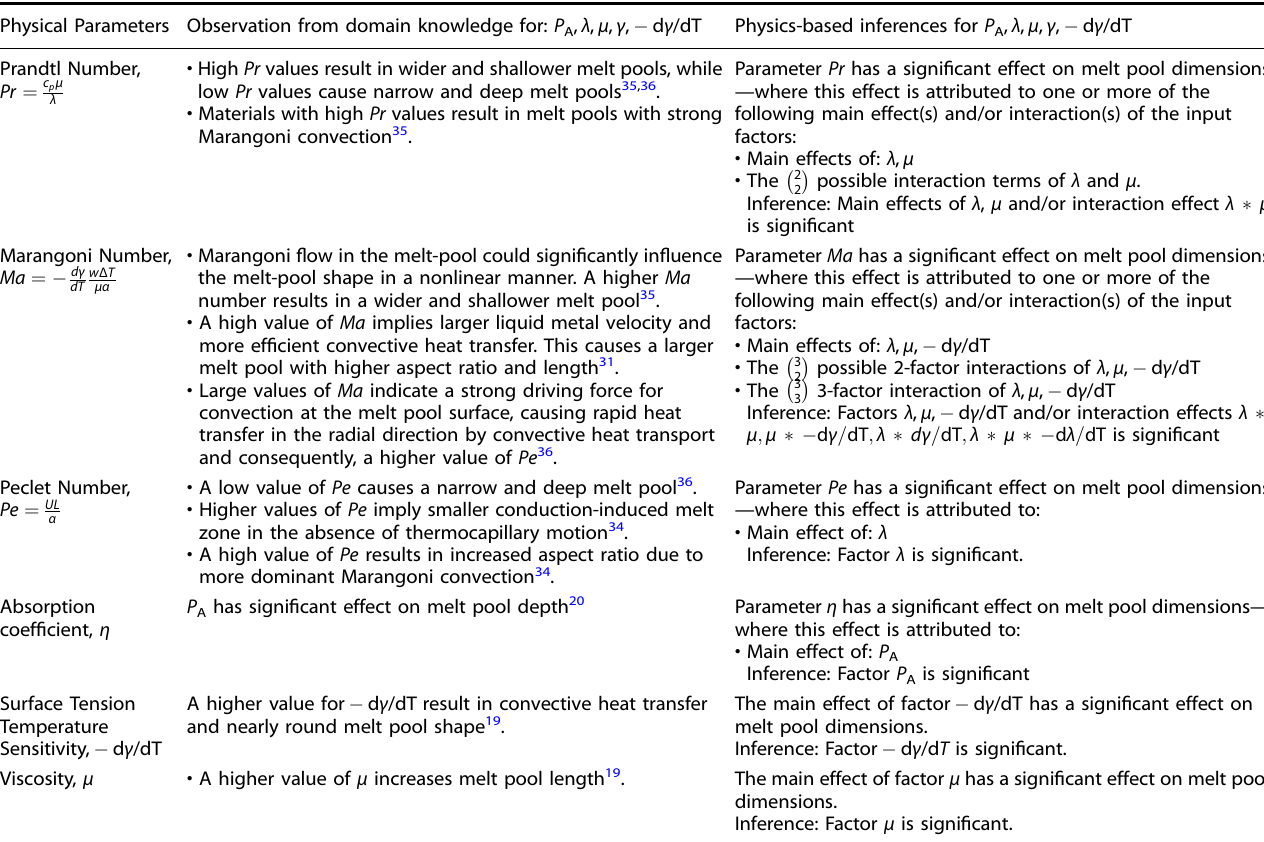
Table 9. Inferences based on domain knowledge. Physical Parameters Observation from domain knowledge for: P A , λ , μ , γ , − d γ /dT Physics-based inferences for P A , λ , μ , γ , − d γ /dT Prandtl Number, Pr ¼ c p μ λ